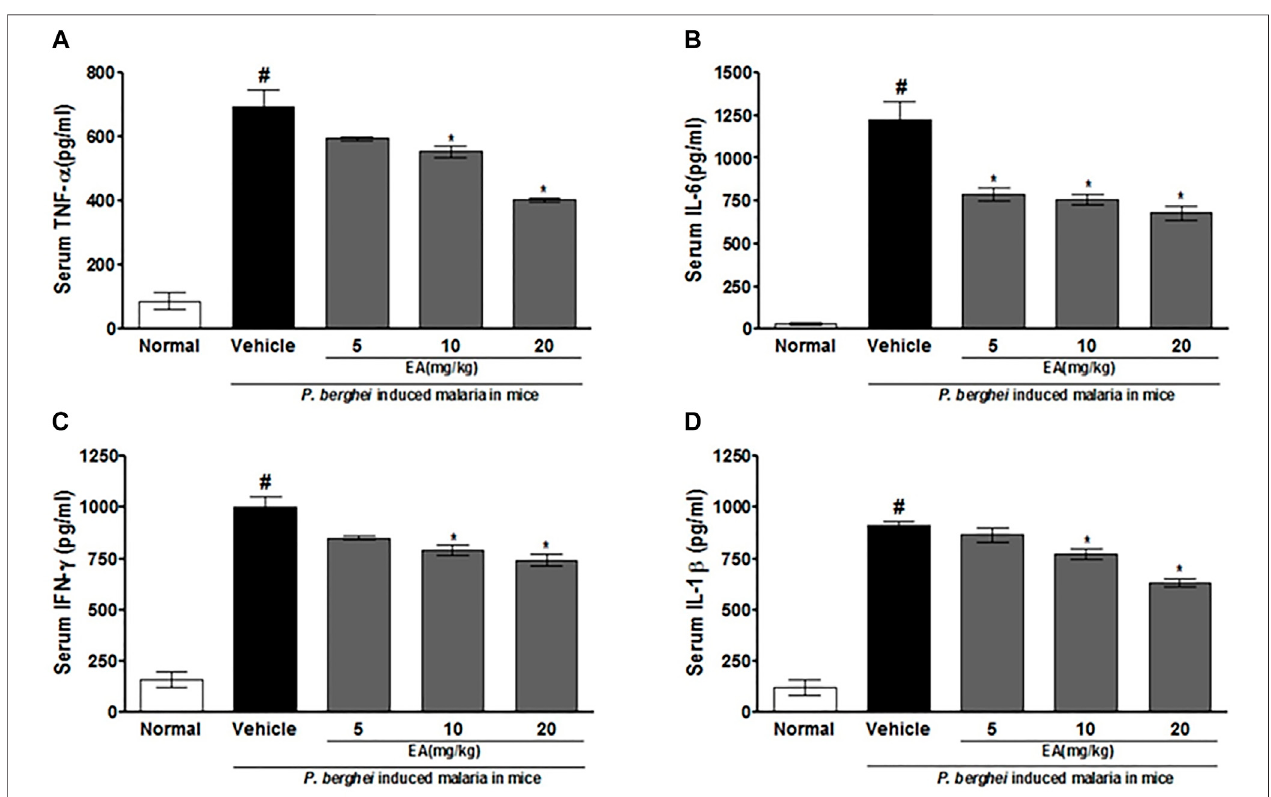
FIGURE 4 | Effect of EA on production of pro-in fl ammatory cytokines TNF-- α , IL-6, IFN- λ and IL-1 β on peak day of parasitaemia in serum in P. berghei infected mice. Date are expressed as Mean ± SEM: P < 0.05; #Normal vs vehicle treated; *Vehicle vs treatment; n (cid:1) 3.